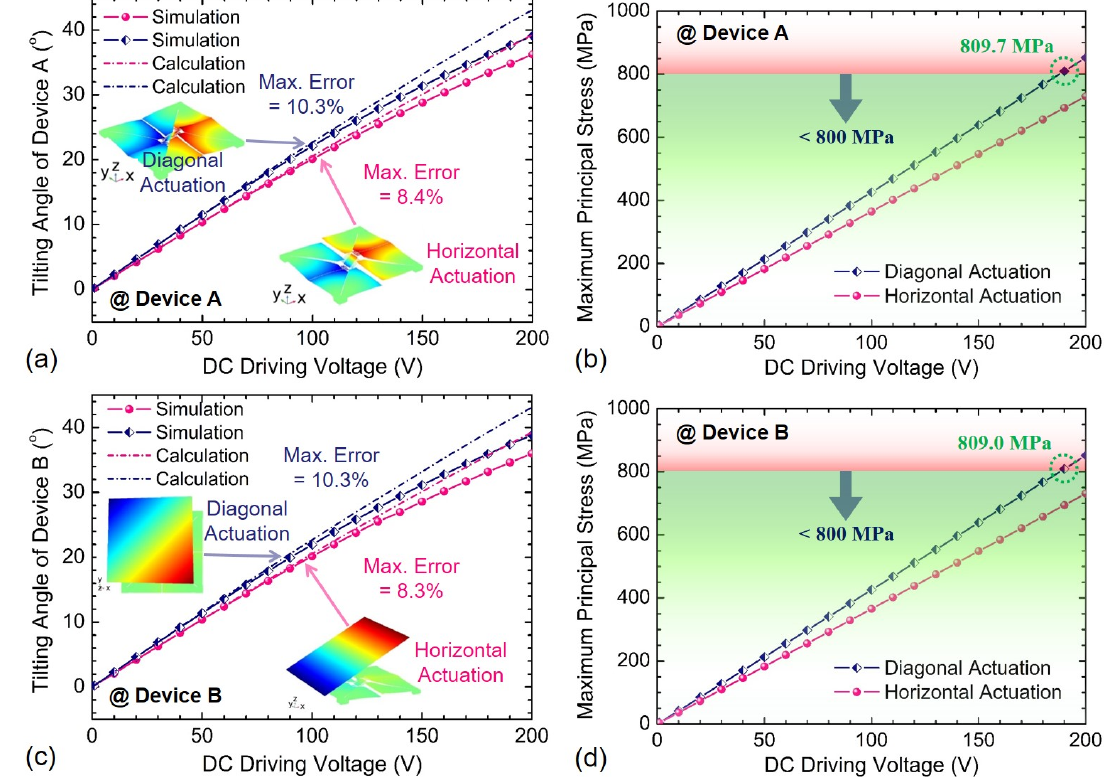
Figure 9. Comparison of dependence of the tilting angle and maximum principal stress on the DC driving voltages: ( a , b ) Device A without gravity, ( c , d ) Device B without gravity.